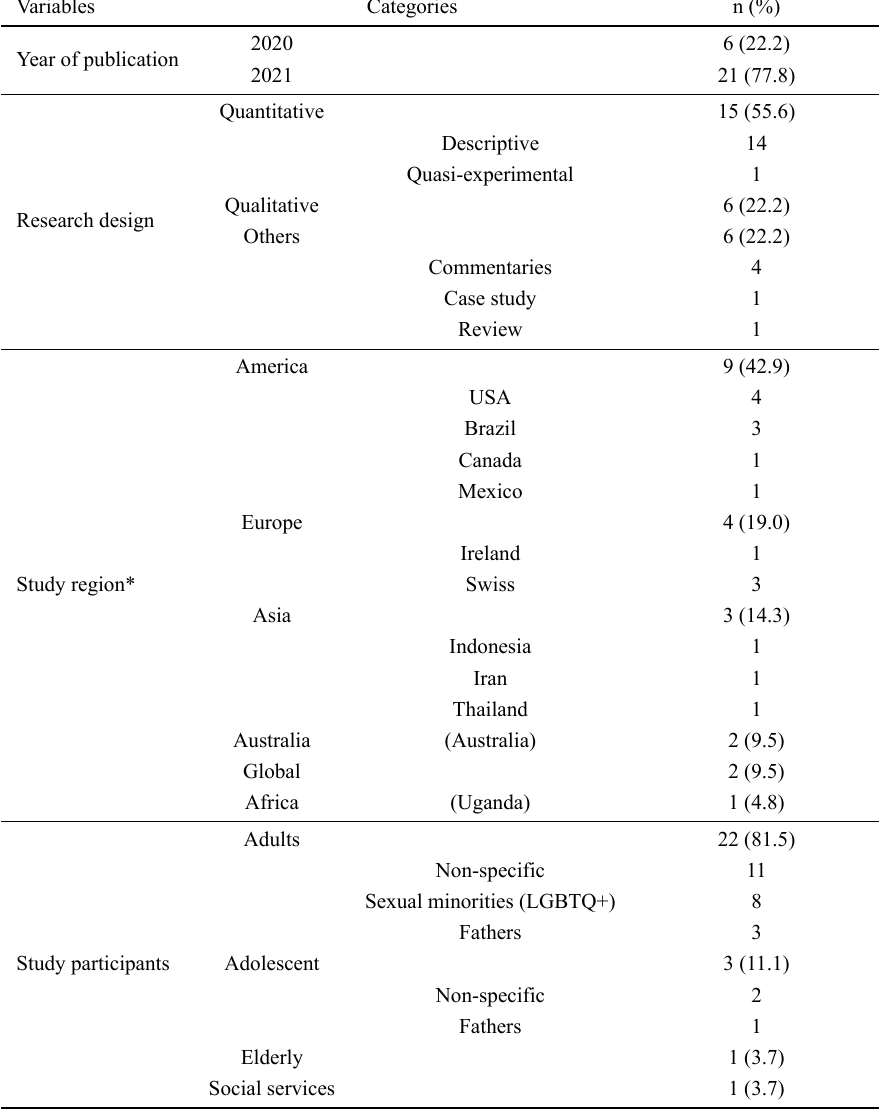
Table 1. Publication characteristics of included studies (n =